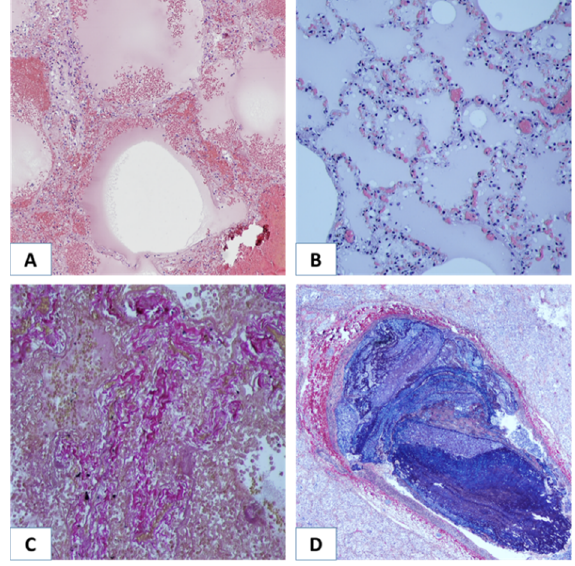
Figure 2. Morphological alterations in lungs of COVID-19 nonsurvivors. ( A ) Hyaline membranes and alveolar edema. Hematoxylin and eosin staining, × 100 magnification. ( B ) Alveolar edema. Hematoxylin and eosin staining, × 100. ( C ) Lung fibrosis. Elastic fibers were stained purple-red to brown. Collagen was stained various shades of red. Weigert–van Gieson staining, × 200. ( D ) Thrombus in the pulmonary artery. PTAH staining, × 40 magnification.